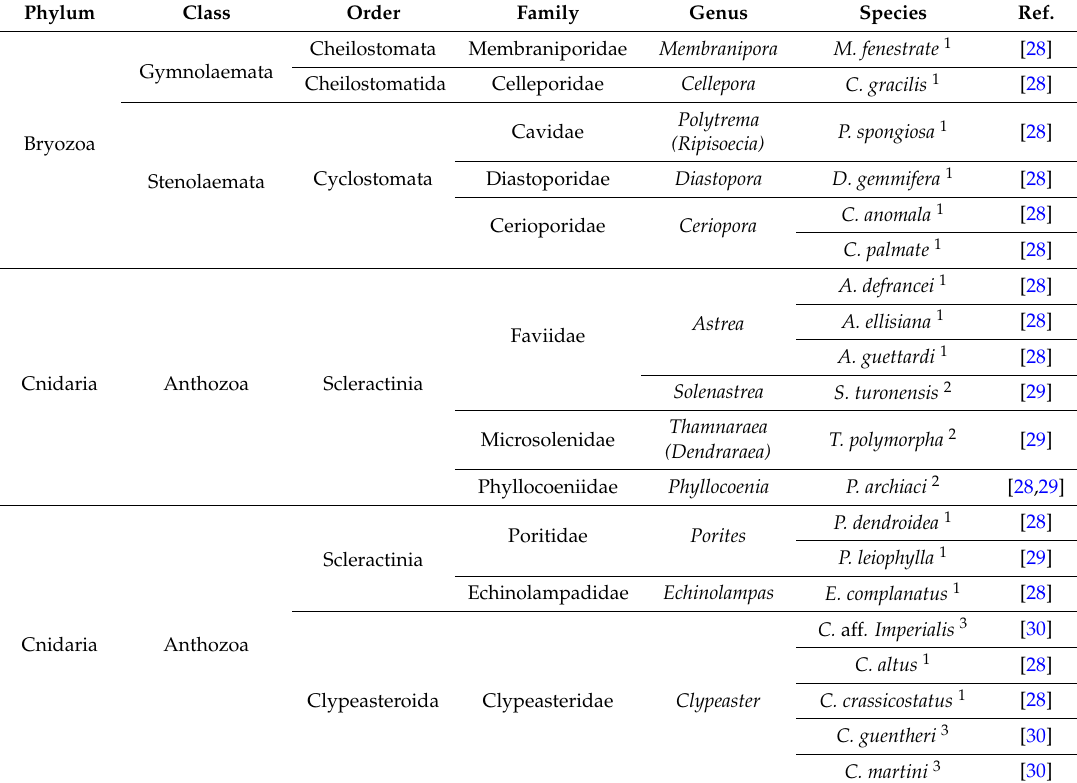
Table 10. List of fossils from the National Park of Urmia